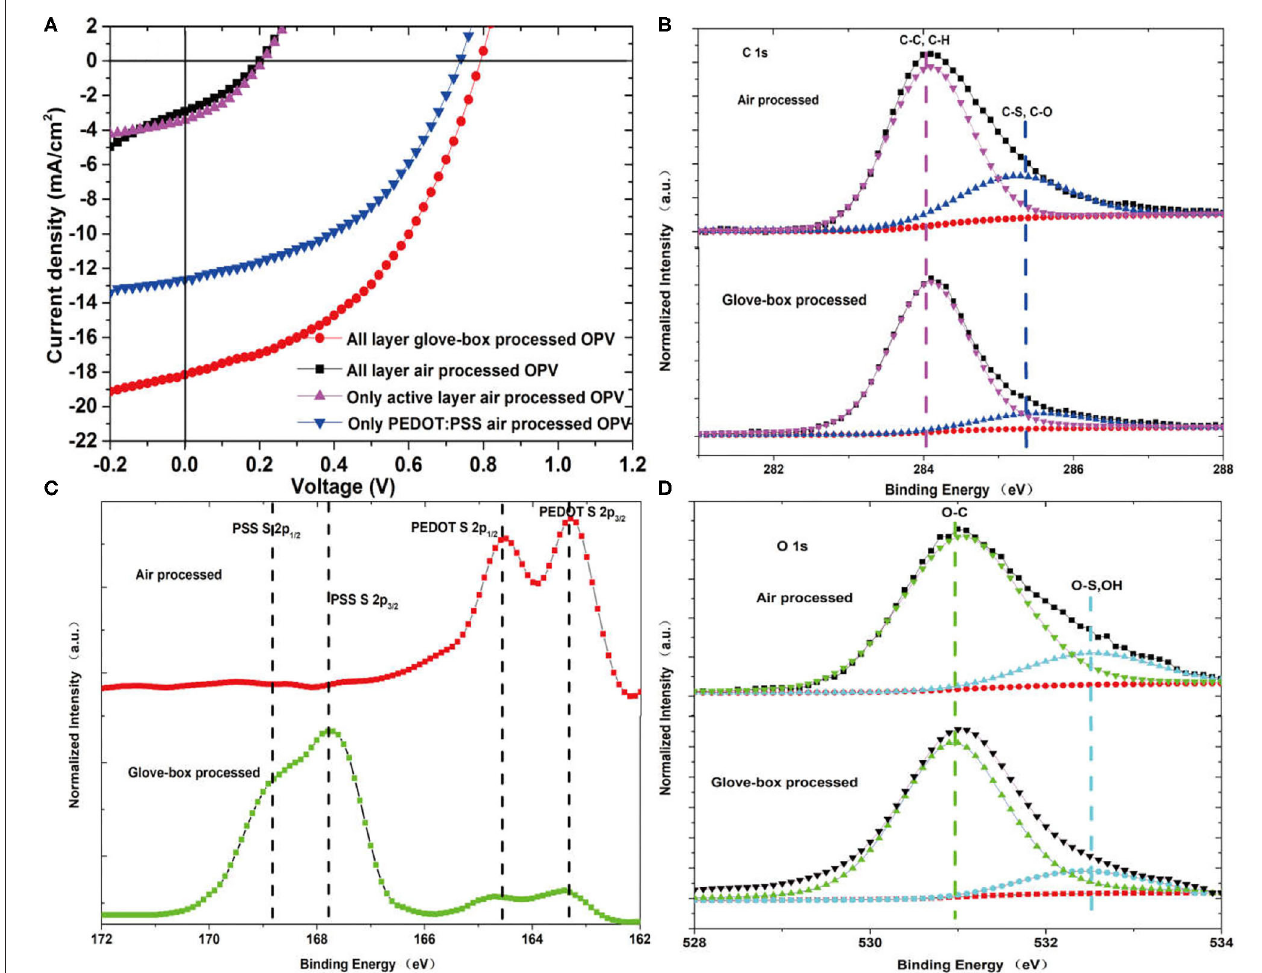
Figure 1C presents the S (sulfur) 2p spectrum of the PEDOT:PSS of glove-box-processed and air-processed organic solar cells. The S 2p spectrum of glove-box-processed OSCs shows a typical S spectra of PEDOT:PSS. The higher binding energy peaks are at 168.8 and 167.8 eV, corresponding to the S atoms in PSS, and the lower binding energy peaks are at 164.6 and 163.3 eV corresponding to the S atoms in PEDOT. The atomic fundamental parameters of sulfur were taken from X-ray lib [13], and these peak values coincide with previous reports [14, 15]. In Figure 1C , the O–S bond in the S 2p spectrum of air-processed OSCs was not observed, which indicates no signal of S atoms of PSS. The missing of the PSS signal leads to a conclusion that PSS undergoes a so-called oxido-de-sulfonato-substitution forming the phenolate. This observation indicates that PEDOT:PSS can be oxidized by oxygen and leads to the damage of the OSCs. We note that PEDOT:PSS is synthesized with a small excess of PSS. Oxygen diffuses into the PEDOT:PSS layer and reacts with